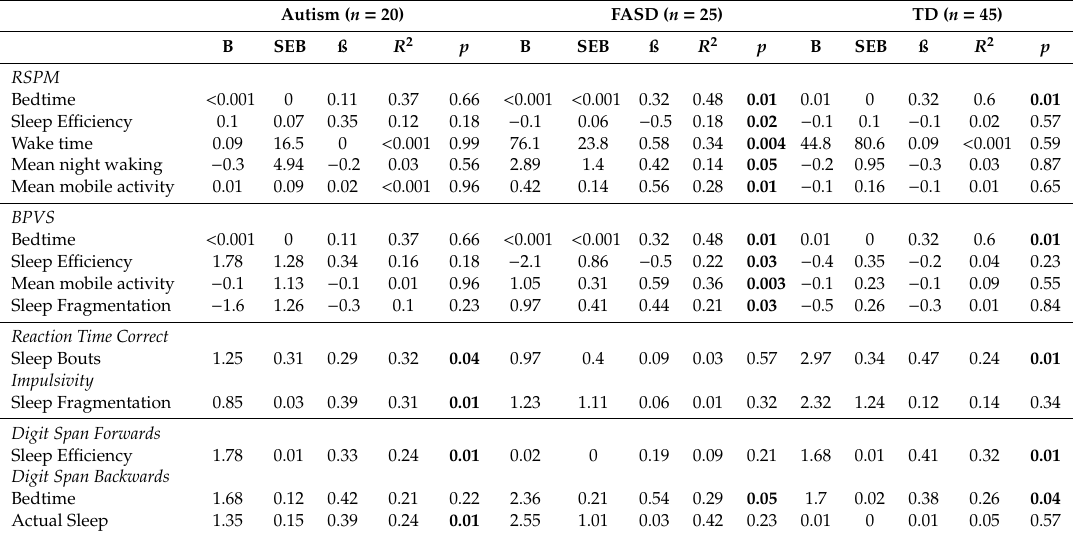
Table 5. Significant regressions between cognition and